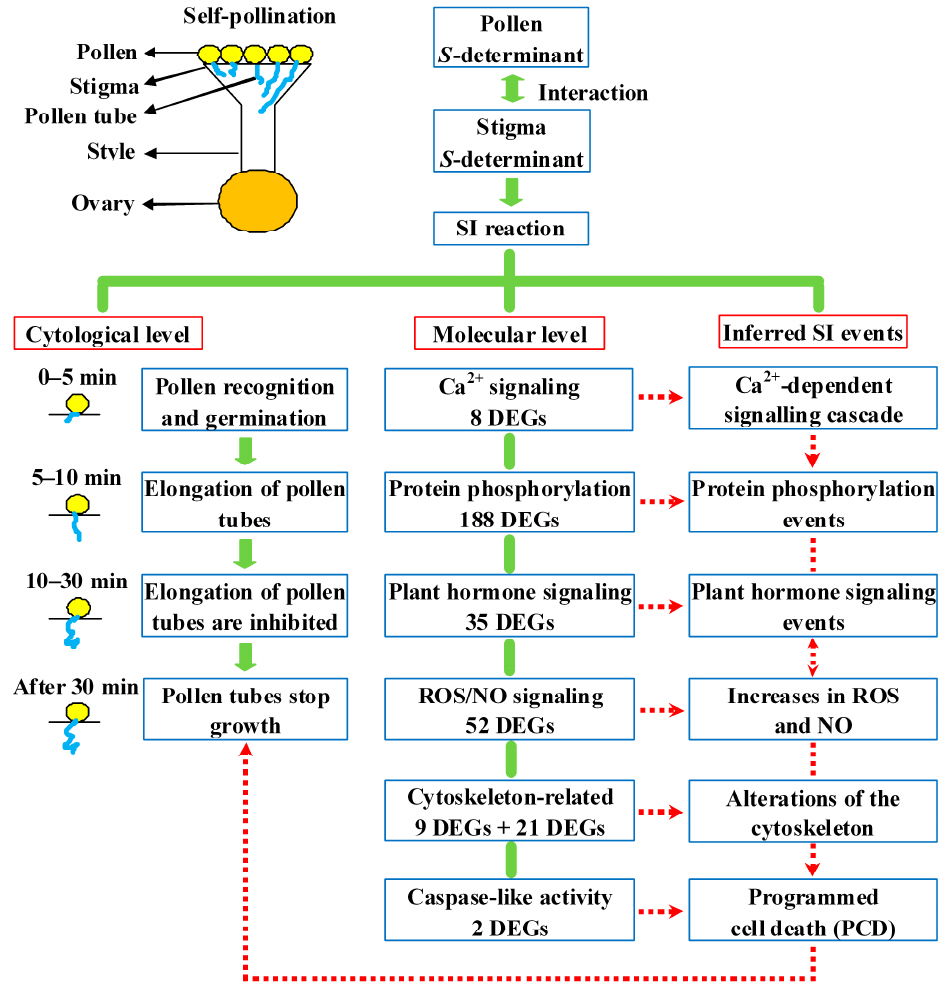
Figure 8. A putative molecular model of the self-incompatibility (SI) response in sheepgrass. Interaction of a stigma S-determinant with its cognate pollen S -determinant rapidly triggered the SI signaling network. Solid segments and arrows show SI-induced reactions at cytological and molecular levels. Dotted segments and arrows show possible SI triggered events. Cytological observation revealed that the self-pollinated pollens can normally germinate at 5 min. However, the elongation of pollen tubes was inhibited from 10 to 30 min, and subsequently, the pollen tube growth stopped. Many SI-related signaling genes and pathways were induced, including genes related to calcium (Ca 2 + ) signaling, protein phosphorylation, plant hormone, reactive oxygen species (ROS), nitric oxide (NO), actin depolymerization, microtubule depolymerization, and programmed cell death (PCD). Thus, SI may trigger a comprehensive calcium- and phytohormone-dominated signaling cascade and activate PCD, which may explain the rapid inhibition of self-pollen tube growth as observed by cytological